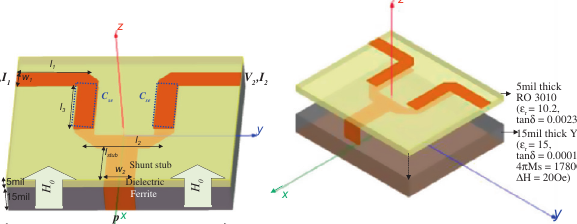
Figure 12. Unit-cell of the proposed coupled CRLH for operation at X -band, the geometry is comprised of a 5 mil thick PCB (RO 3010) placed on a 15 mil thick YIG biased normal to the ground plane. Its exploded view explicitly shows the constituent layers. The dimen- sions are: l 1 = 32.5, l 2 = 40, w 1 = 10, w 2 = 15, l 3 = 37, l stub = 30